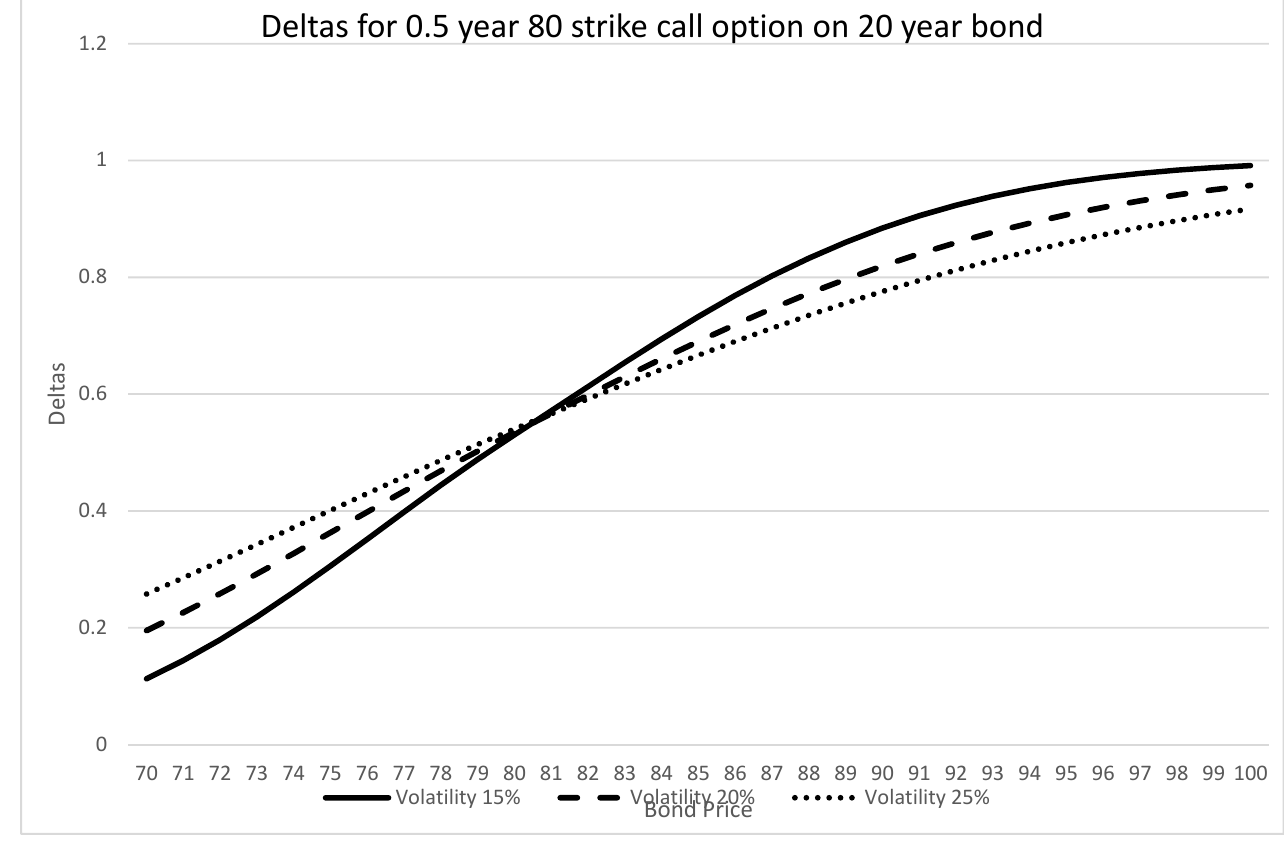
Figure 2. PTP deltas at different volatilities.